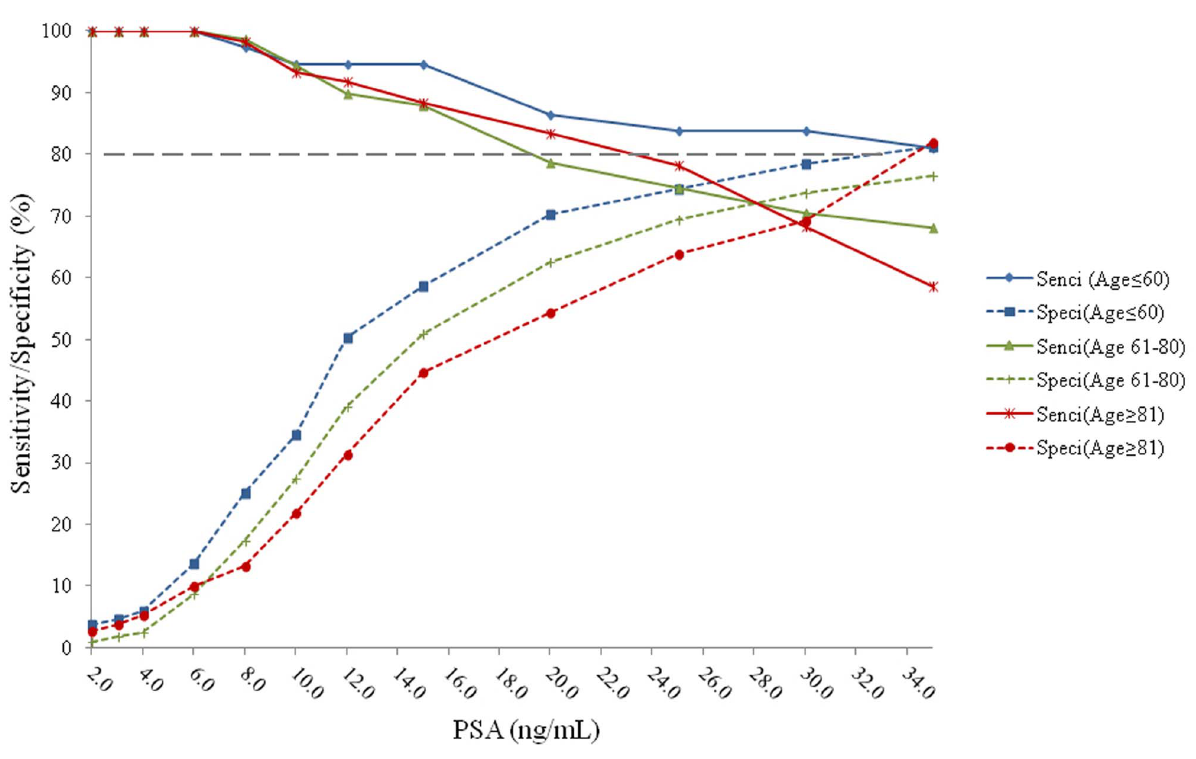
Figure 3. Sensitivities and specificities of PSA predicting Gleason Socre $ 8 vs. Gleason Score , 8 plus non-PCa in different age groups. The sensitivity was 88% and specificity was 69% with tPSA cutoff value of 19.0 ng/mL in the age # 60 group; the sensitivity was 78% and specificity was 62% with tPSA cutoff value of 21.0 ng/mL in the age 61–80 group; the sensitivity was 80% and specificity was 59% with PSA value of 23.0 ng/mL in the age $ 81 group. (analyzed by using multi-variate logistic regression including tPSA, %fPSA and total prostate volume) were measured within different age groups. Statistical analyses were performed using SPSS 19.0